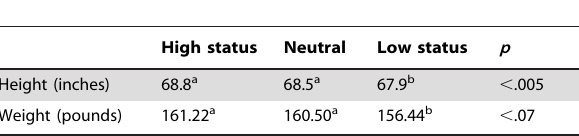
Table 1. Perceived size as a function of status cues in Experiment